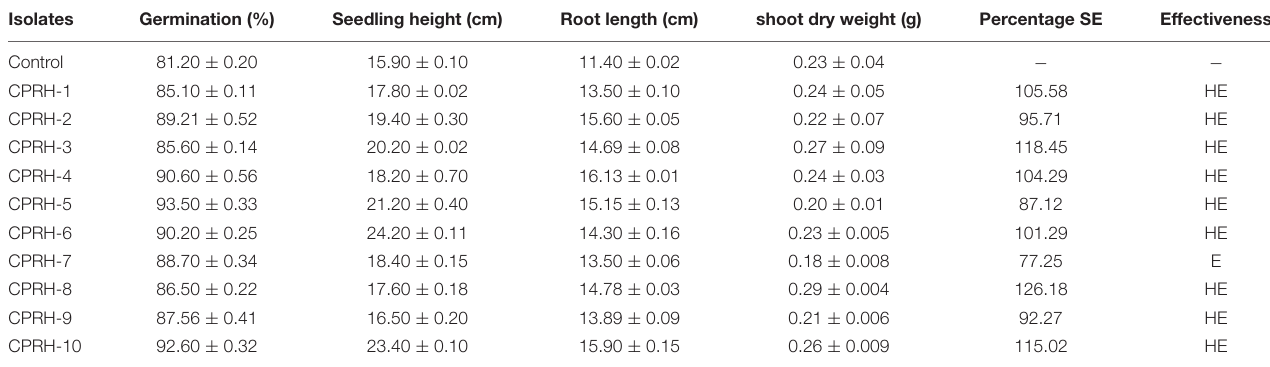
TABLE 3 | Effect of Rhizobium inoculation on growth and symbiosis effectiveness in pot study. Isolates Germination